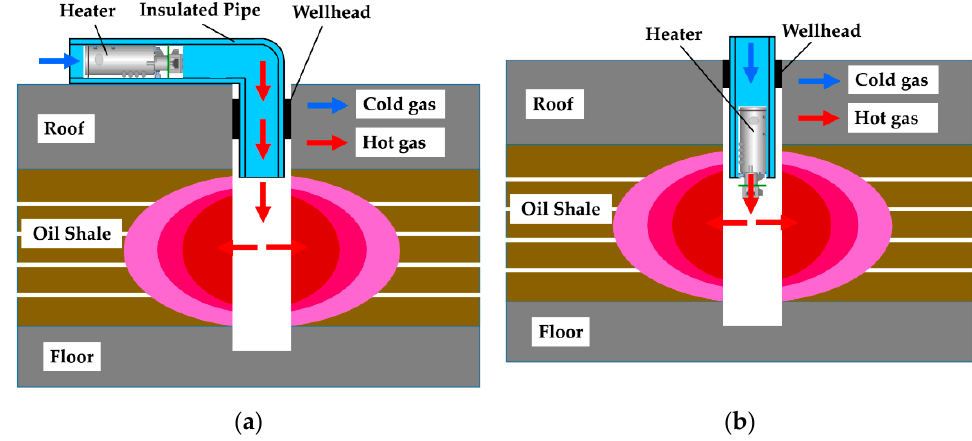
Figure 1. Formation heating technology [13]. ( a ) Ground heating technology. ( b ) Downhole heating technology. Reprinted with permission from Ref. [13] Copyright 2018 Applied Thermal Engineering, Elsevier.